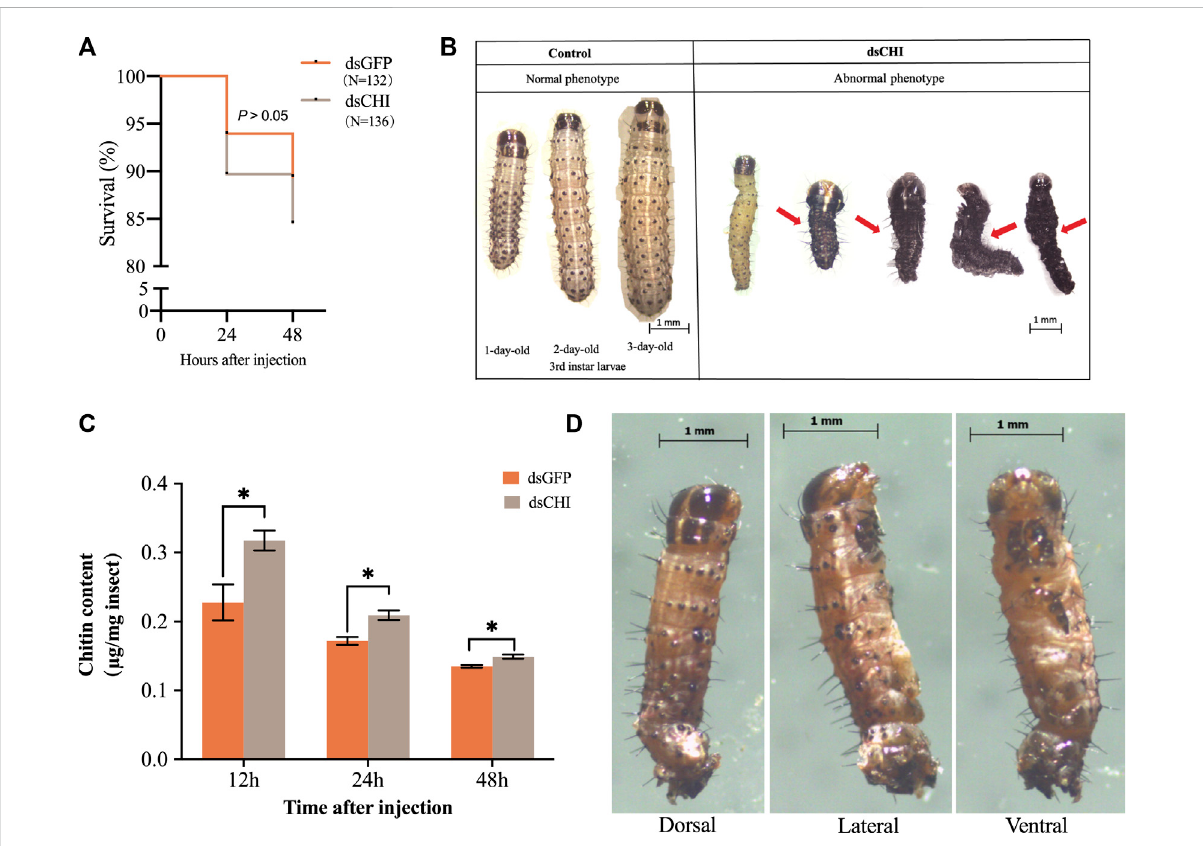
Survival (A) , abnormal phenotype (B , D) and chitin content (C) changes of Spodoptera frugiperda after RNAi. The numbers of Spodoptera frugiperda larvae used to count the survival rate of dsGFP and dsCHI groups were 132 and 136, respectively. Larvae at the fi rst day of the third instar stage were divided into three groups and injected with dsGFP and dsCHI, respectively. Insects were collected and used to determine chitin content (C) . Three replicates were performed per group. Figure 3D showed one type of death phenotype in the dsCHI treatment. (Mean ± SE;